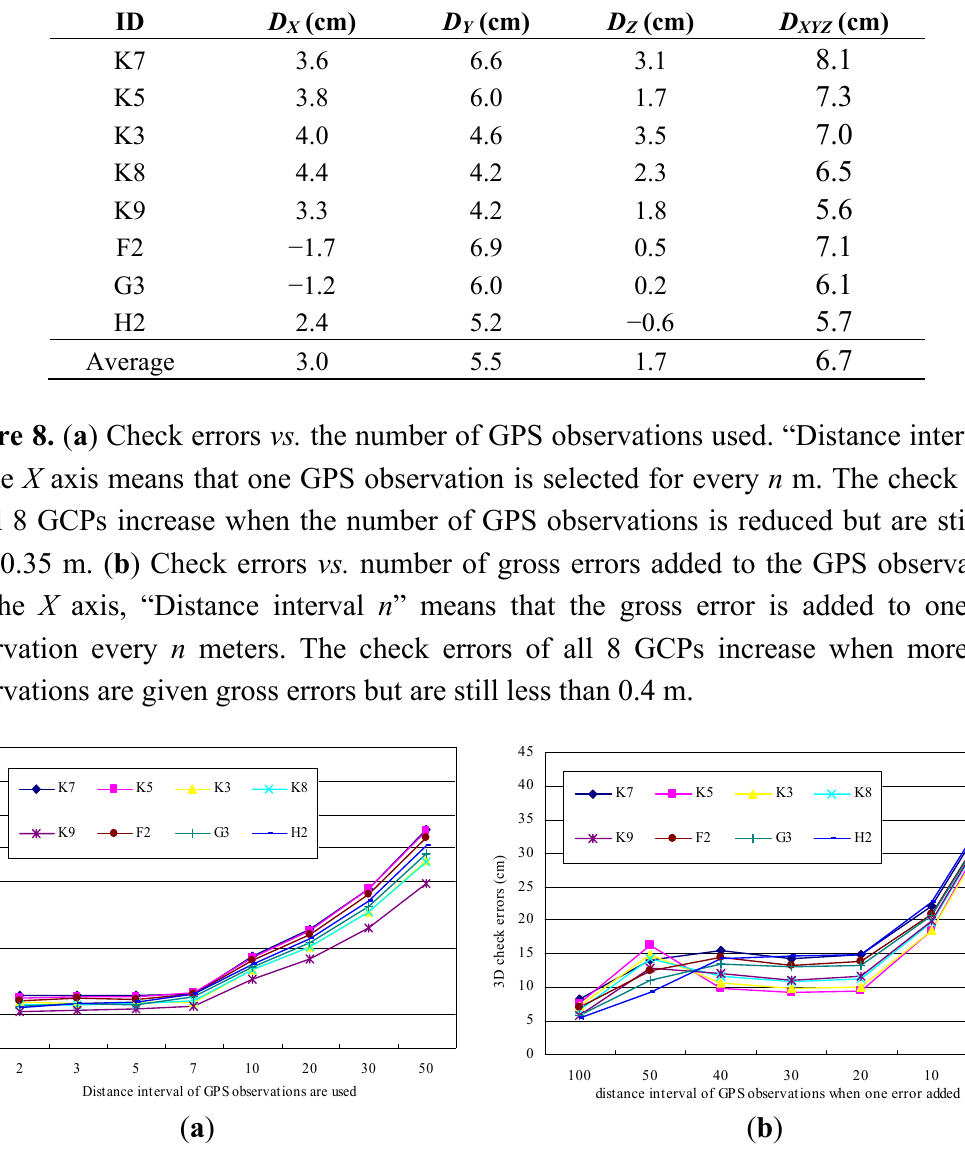
Table 1. Check errors of the eight GCPs.